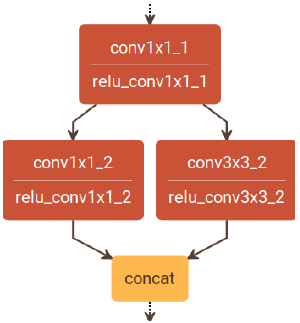
Figure 2. Architecture of a Fire module. A so called squeeze operation is performed by the 1x1 convolutional layer. Subse- quently an expand operation that is a combination of 1x1 and 3x3 filters increases the number of activation maps while keeping the number of parameters